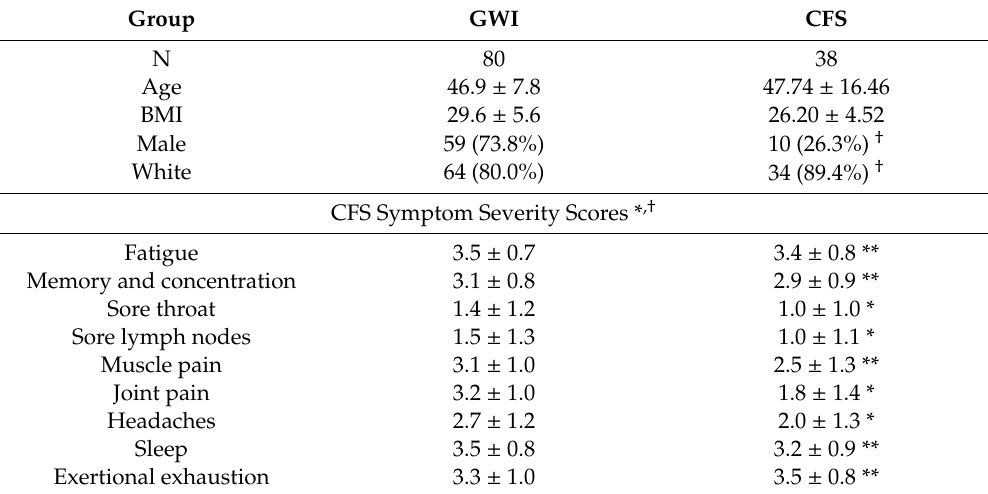
Table 1. Demographics (mean ±